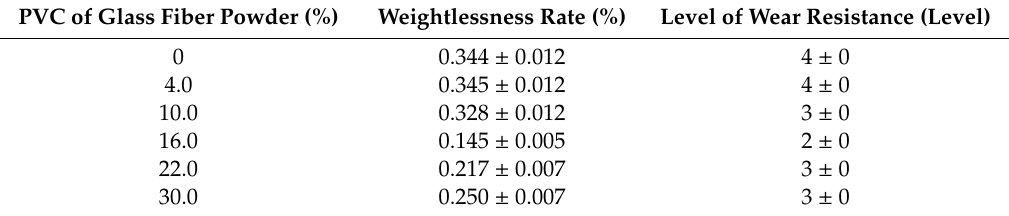
Table 5. Influence of the PVC of glass fiber powder on wear resistance of the thermochromic waterborne coating.